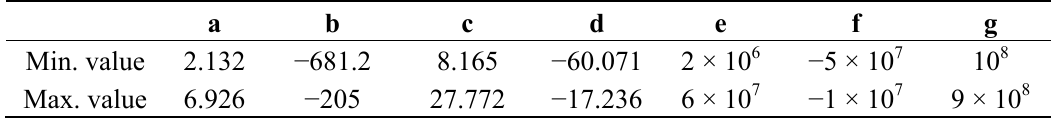
Table 5. Min. and Max. values for average